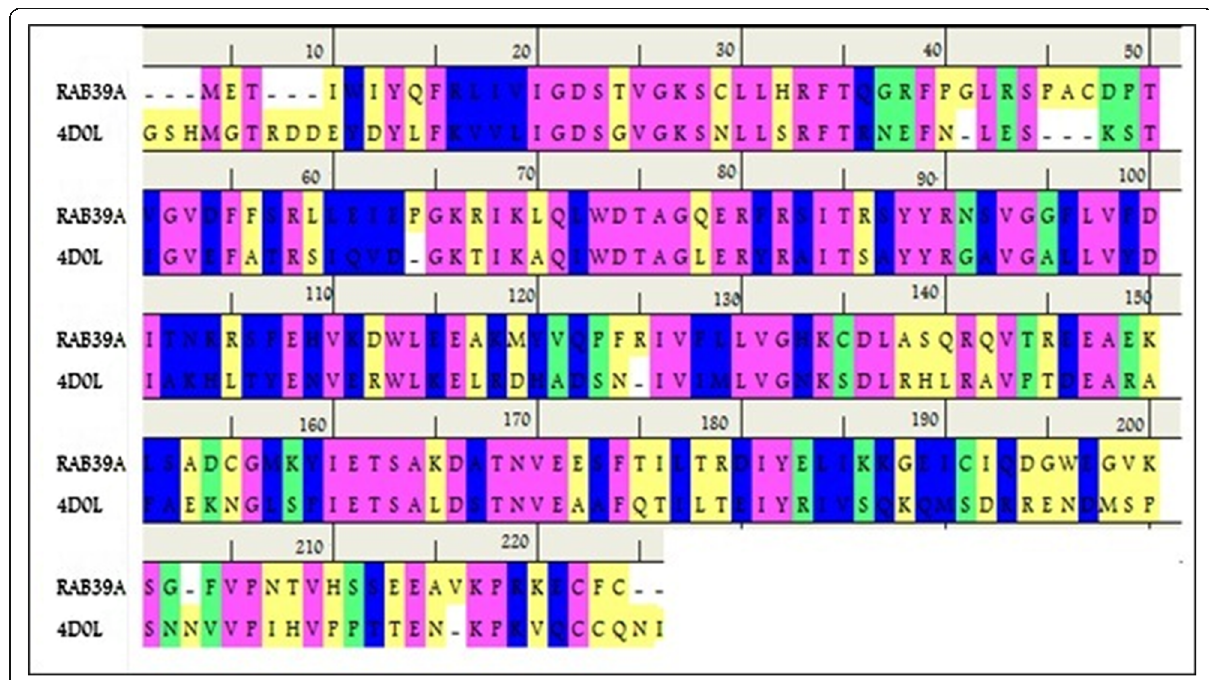
Fig. 3 Sequence alignment of Rab39a with template protein: The pairwise sequence alignment between two proteins was carried out using ClustalW [16]. The conserved residues (96.45%) are represented in pink color, while highly and weakly similar residues (3.55%) in blue and green color,